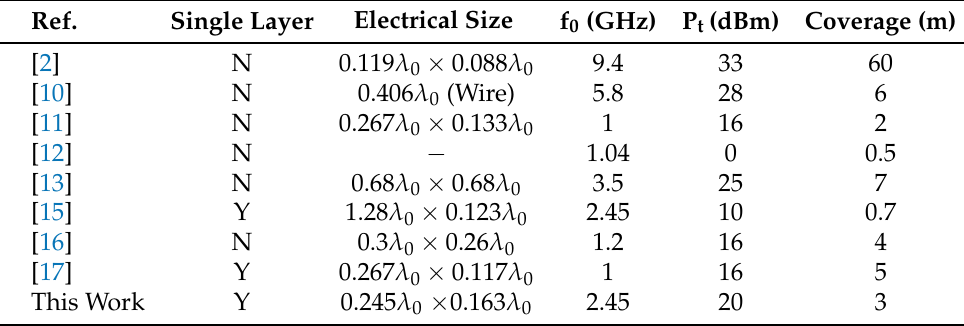
Table 1. Recently published harmonic